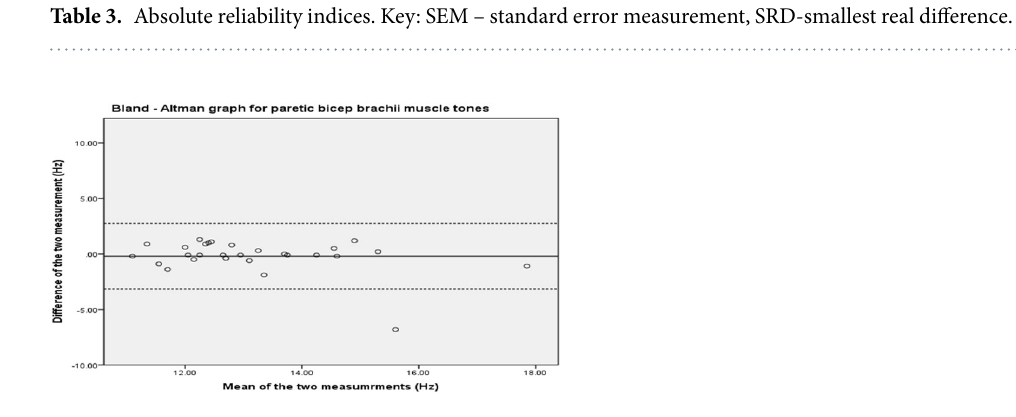
Figure 1. Bland-Altman analysis plot for biceps brachii.